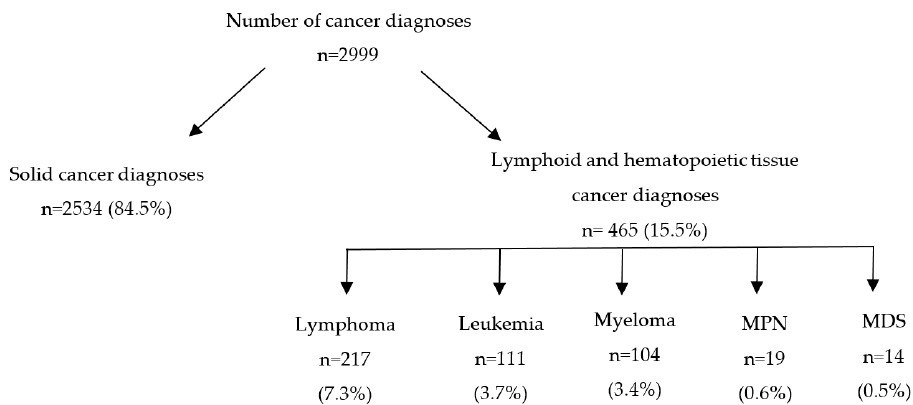
Figure 2. Distribution of solid, lymphoid and hematopoietic tissue cancer diagnoses in the WTC EHC